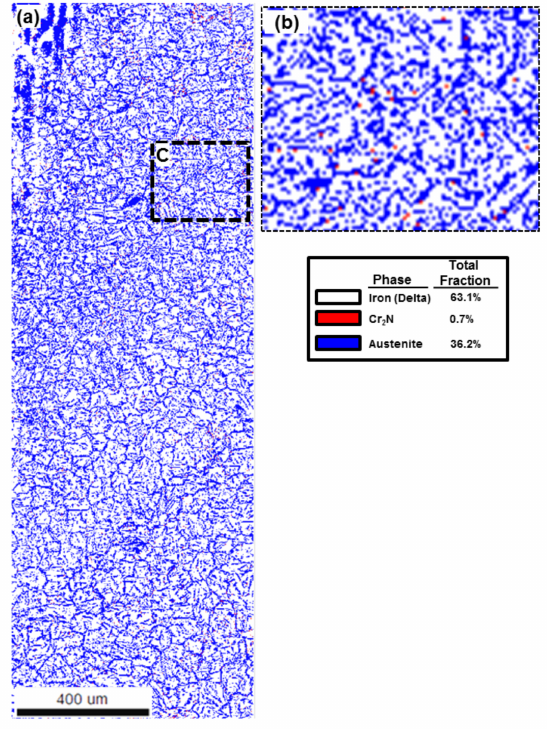
Figure 11. EBSD results at the edge of high heat input weld: ( a ) phase map; and ( b ) magnification at location ‘C’ of ( a